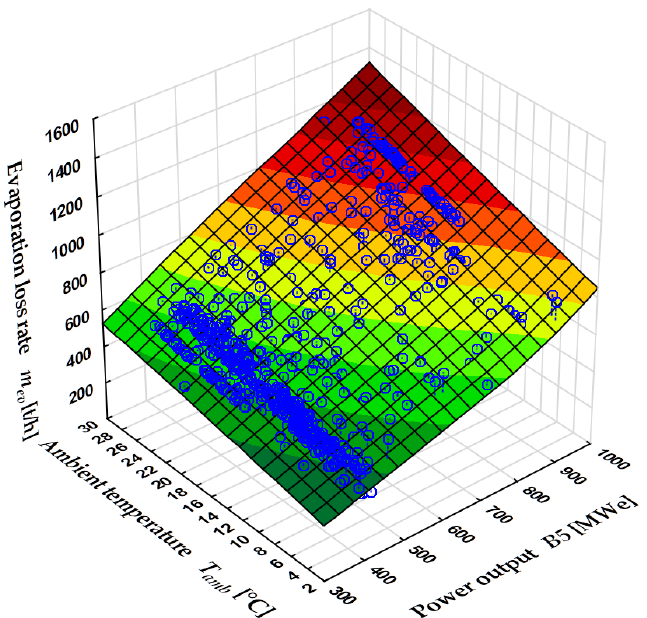
. m ev as a function of ambient temperature T amb and power output Figure 6. The evaporated water flux Figure 6. The evaporated water flux 𝑚̇ 𝑒𝑣 as a function of ambient temperature T amb and power out- of power unit 5 B 5 for humidity range of = 70 ± 5%. Source: own elaboration (Statistica put of power unit 5 𝐵 5 for humidity range of = 70 ± 5% . Source: own elaboration (Statistica soft- ware).